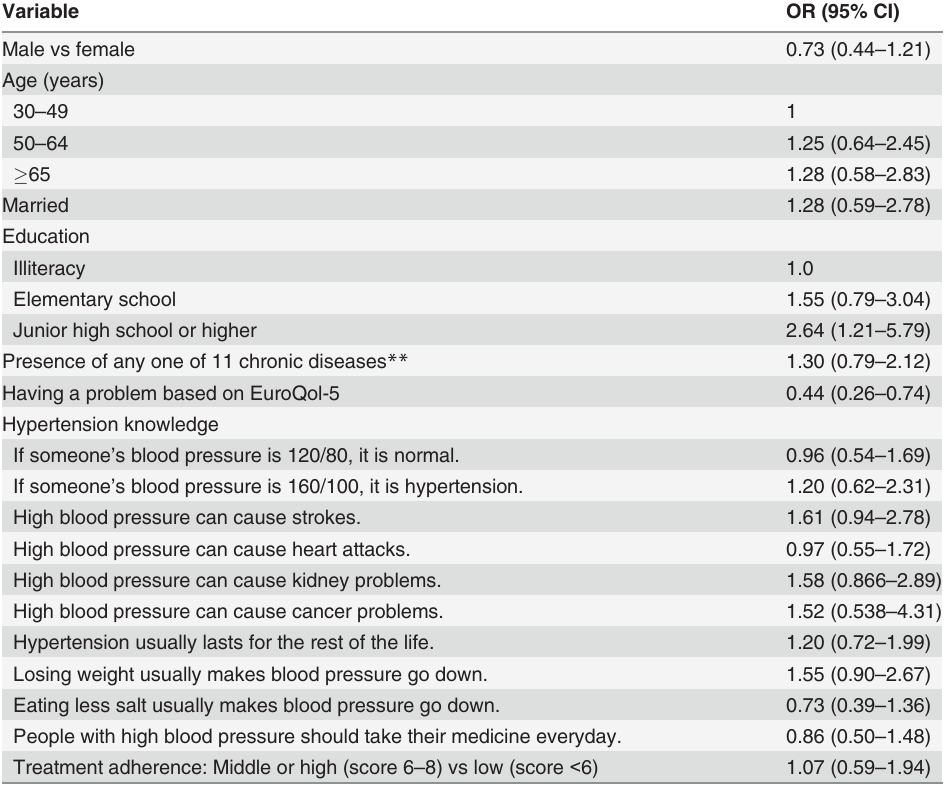
Table 5. Adjusted odds ratio (OR) and 95% confidence interval (95% CI) for factors associated with Chinese herbal therapy use * among patients with diagnosed